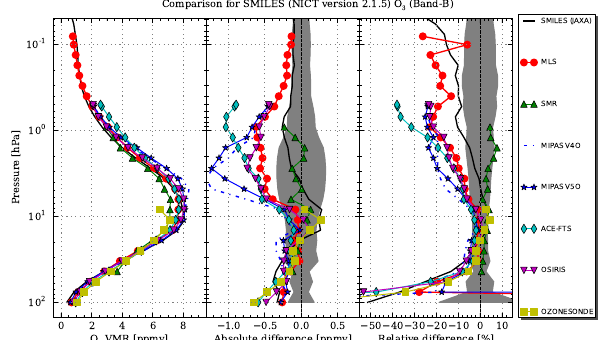
Fig. 22. Left panel: comparison of ozone retrieval between SMILES and TELIS on 24 January 2010. The dashed horizontal maroon line indicates the observing altitude of TELIS. The geolocation infor- mation is: 63 ◦ N, 24 ◦ E for SMILES-1, 64 ◦ N, 31 ◦ E for SMILES- 2, and 66 ◦ N, 27 ◦ E for TELIS. The time difference of the SMILES and TELIS measurements was about 0.5h. Right panel: the corre- sponding averaging kernels for the TELIS retrieval. Fig. 23. Synthesis plots for O 3 profiles (left panel), mean absolute differences (middle panel) and mean relative differences (right panel) of profile comparisons. Each line shows global comparison between SMILES Band-A and another instrument. Dark gray zone indicates systematicerrorofSMILESdiscussedinSect.2.3.